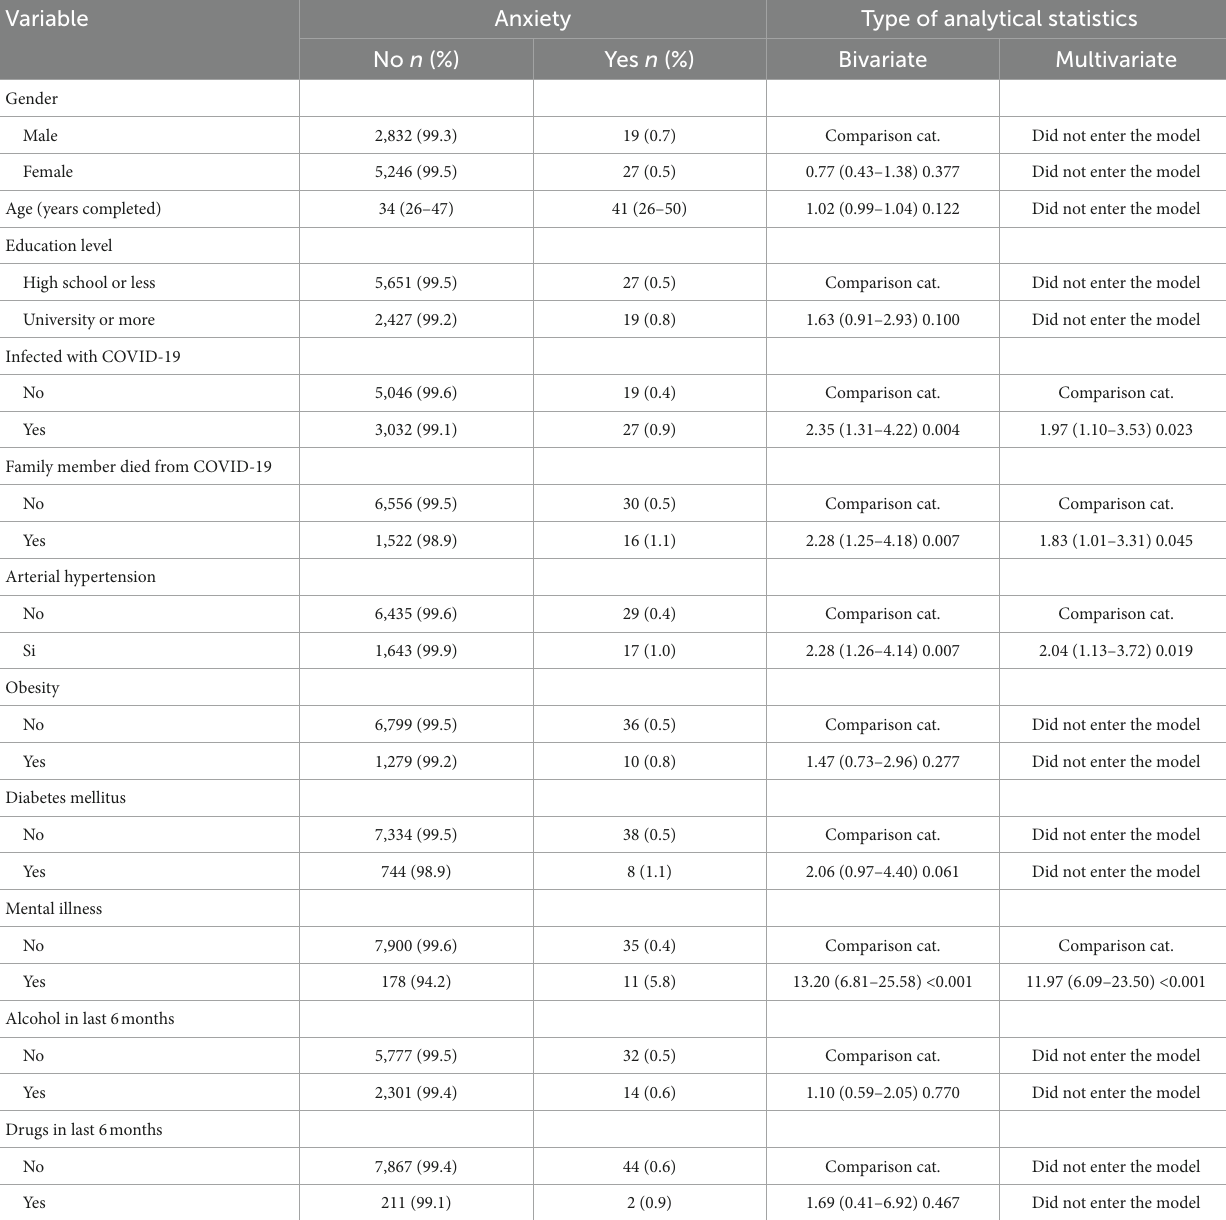
TABLE 4 Factors associated with anxiety in residents of Honduras in the COVID-19 pandemic, in the period 2021–2022, ( n =